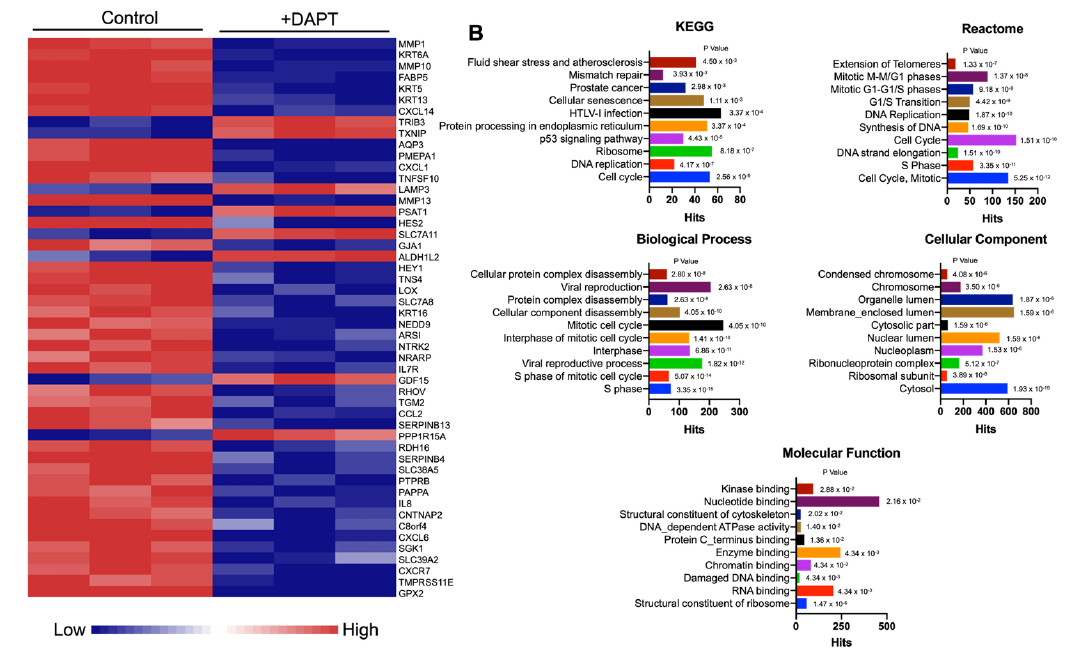
Figure 2. Differential gene expression analysis of a DAPT-treated human oral squamous cell carcinoma cell line (HSC-4). Cells were treated with DAPT for 24 h ( n = 3). The differential gene expression was determined using a high throughput RNA sequencing analysis. ( A ) Heatmap of the top 50 differentially expressed genes. ( B ) The differentially expressed genes were analysed to identify related affected pathways using KEGG enrichment analysis, Reactome Pathway Database and GO terms (cellular component, molecular function, and biological